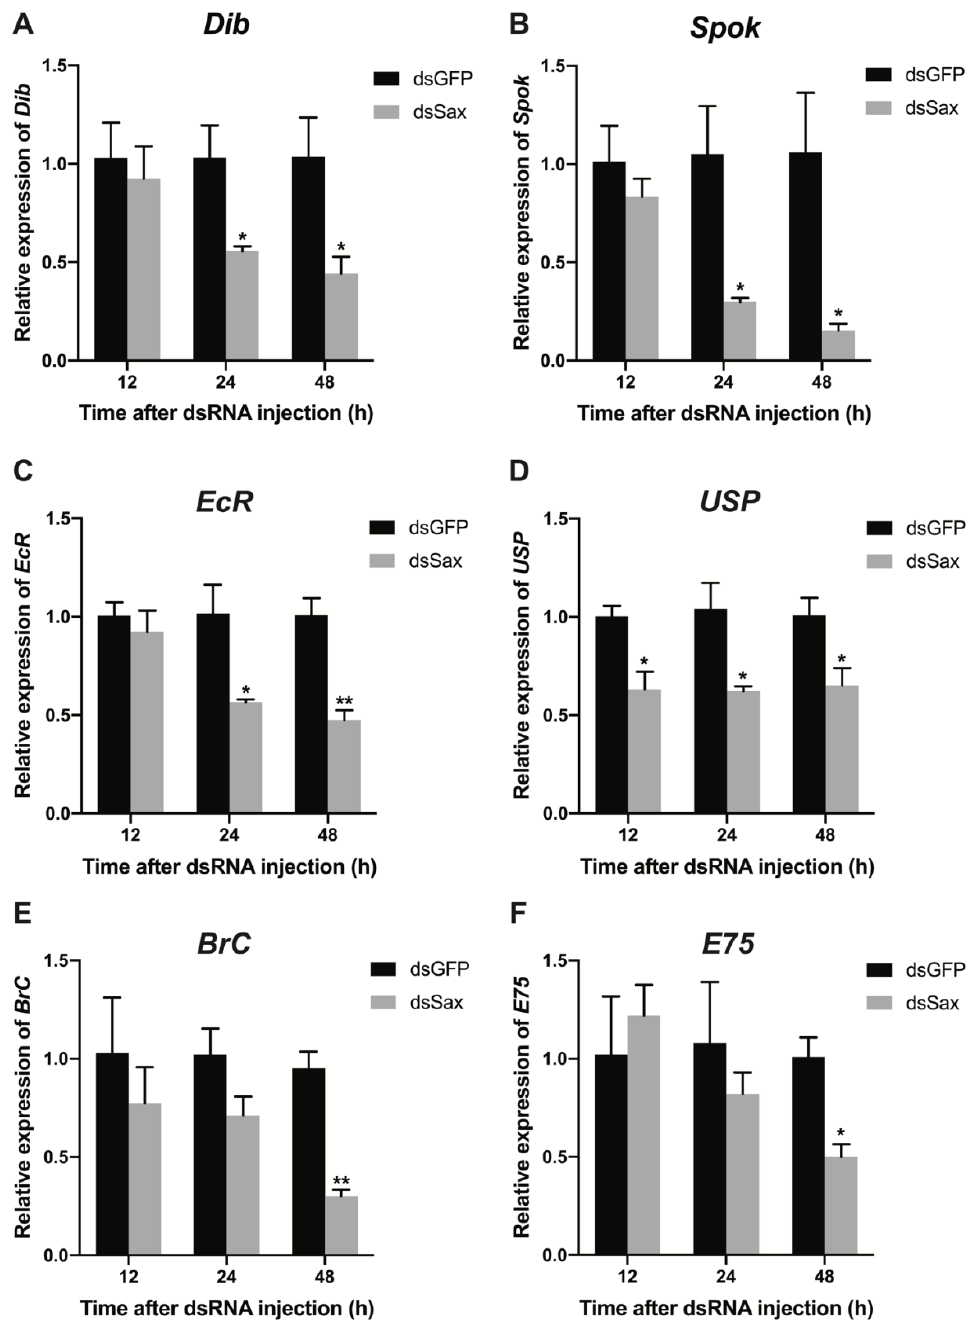
Figure 7. The effects of Sax RNAi on the expression of 20E pathway genes. ( A,B ) Relative expression levels of 20E biosynthesis genes Dib and Spok 12, 24 and 48 h post dsGFP (100 ng/larva) or dsSax (100 ng/larva) injection. ( C,D ) Relative expression levels of 20E receptor genes EcR and USP 12, 24 and 48 h post dsGFP (100 ng/larva) or dsSax (100 ng/larva) injection. ( E,F ) Relative expression levels of 20E downstream genes BrC and E75 12, 24 and 48 h post dsGFP (100 ng/larva) or dsSax (100 ng/larva) injection. Asterisks above bars indicate significant differences between the treatment and corresponding control, * p < 0.05, ** p < 0.01 by t -test.